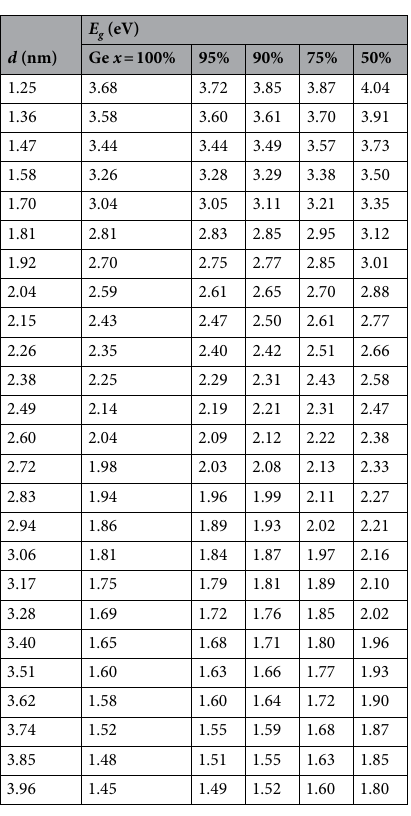
Table 1. Calculated energy gap E g for H-passivated Ge x Si 1− x NCs.